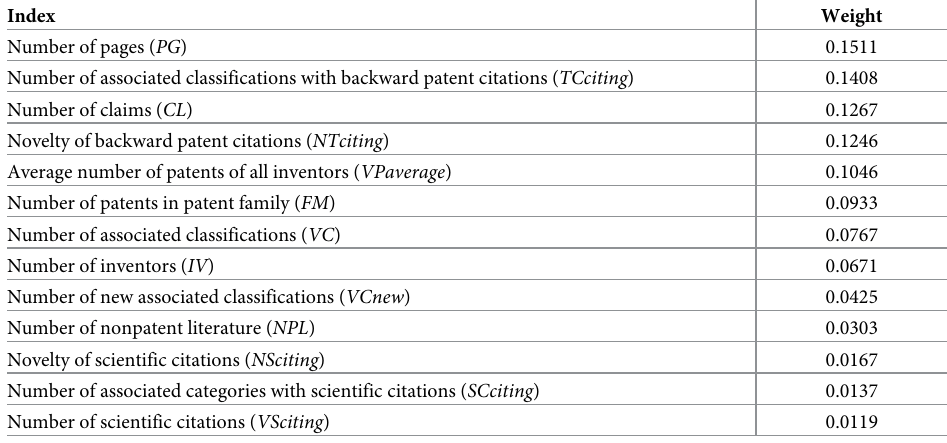
Table 6. The index system of highly cited patents in the electric vehicle domain based on the SVM model.